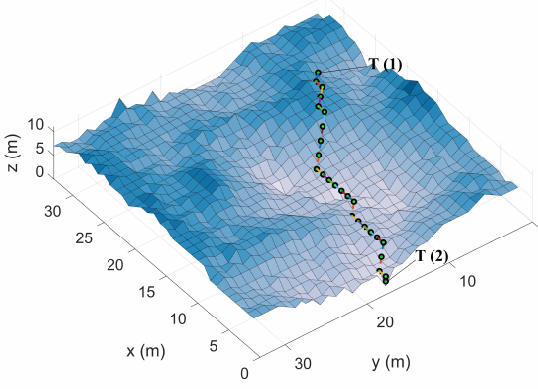
Figure 13. The path of the CM ( i , j ) calculated by the R-Dijkstra algorithm.